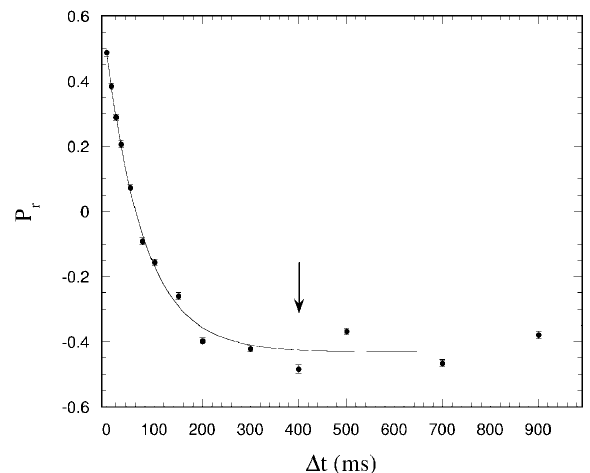
FIG. 3. The measured radial proton polarization at 120 MeV is plotted against the rf dipole ramp time D t . The frequency range R B dl was 0.06 T mm. The D f was 10 kHz, and the rf dipole’s curve is a fit to the data using Eq. (7). The arrow shows the D t value used for Fig. 4.